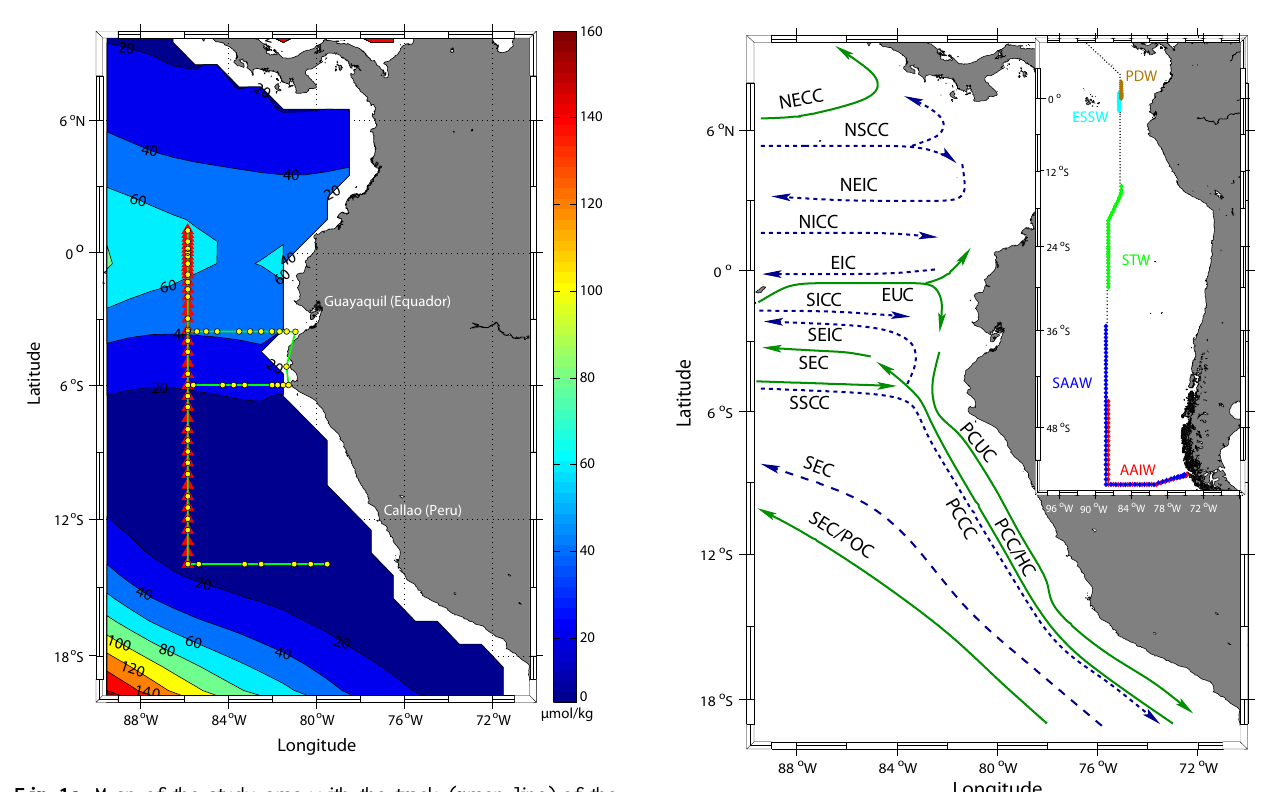
Fig. 1a. Map of the study area with the track (green line) of the Meteor M77 cruise (February 2009) and stations between 14 ◦ S and 1 ◦ N (red triangles) of the WOCE P19 cruise (March 1993). The yellow dots indicate the rosette stations of the M77 cruise selected for the extended OMP analysis. The background shows the climatological mean of dissolved oxygen (µmolkg − 1 ) at 200dbar from the World Ocean Atlas 2009 (data available at http://www. nodc.noaa.gov/OC5/WOA09/pr_woa09.html).